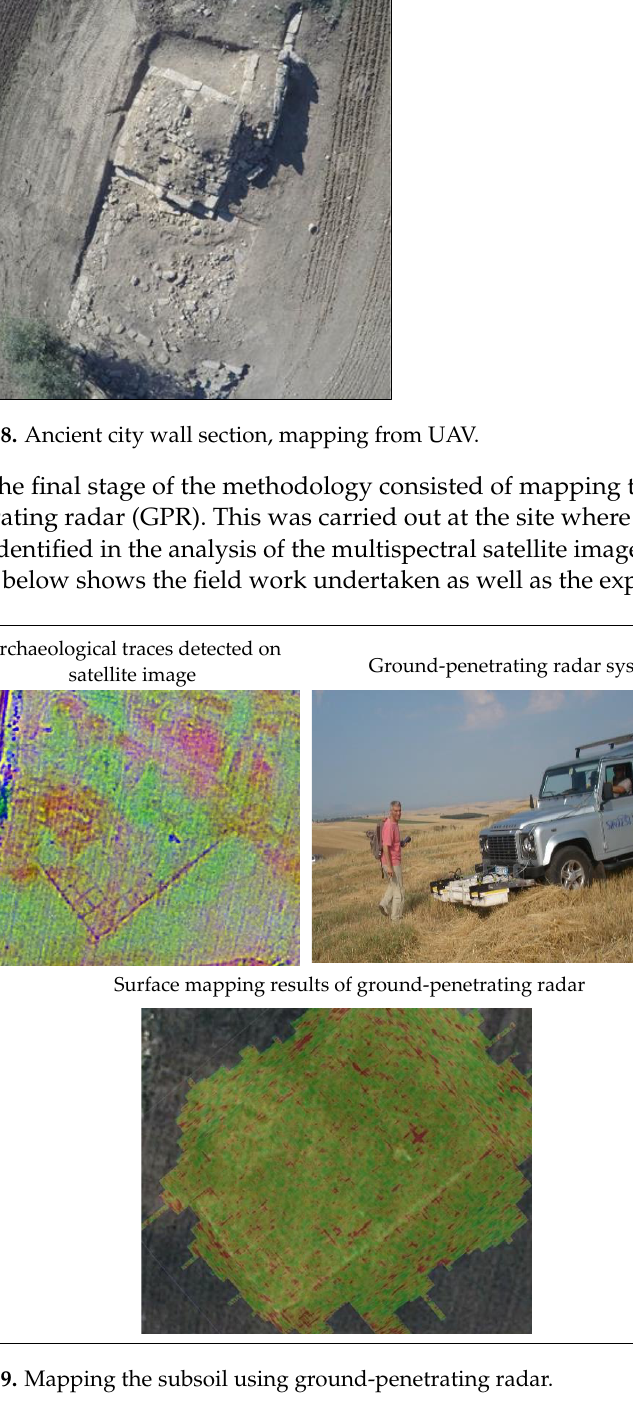
Plot: GeoEye-1 Sat. image, October 2nd Plot: GeoEye-1 Sat. image, May 4th Overall study area